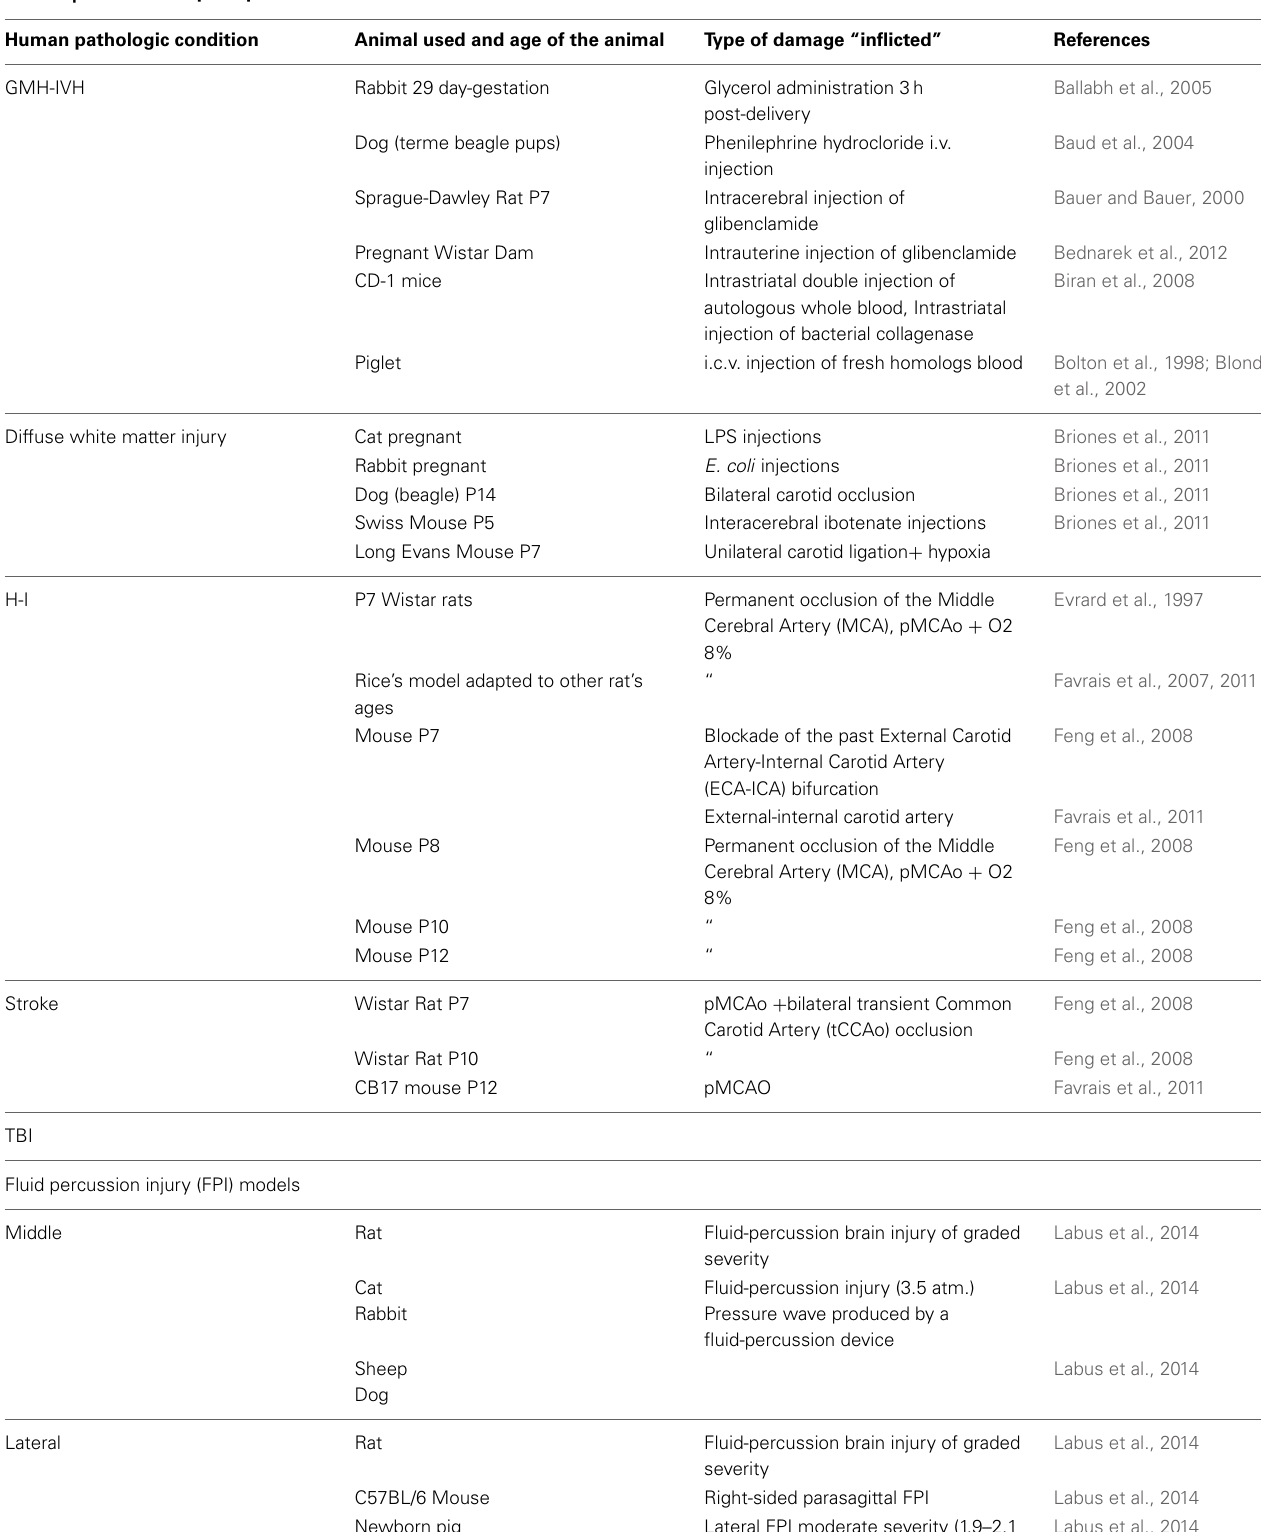
Table 1 | Some of the principal animal models mentioned in this review with correlate references. Human pathologic